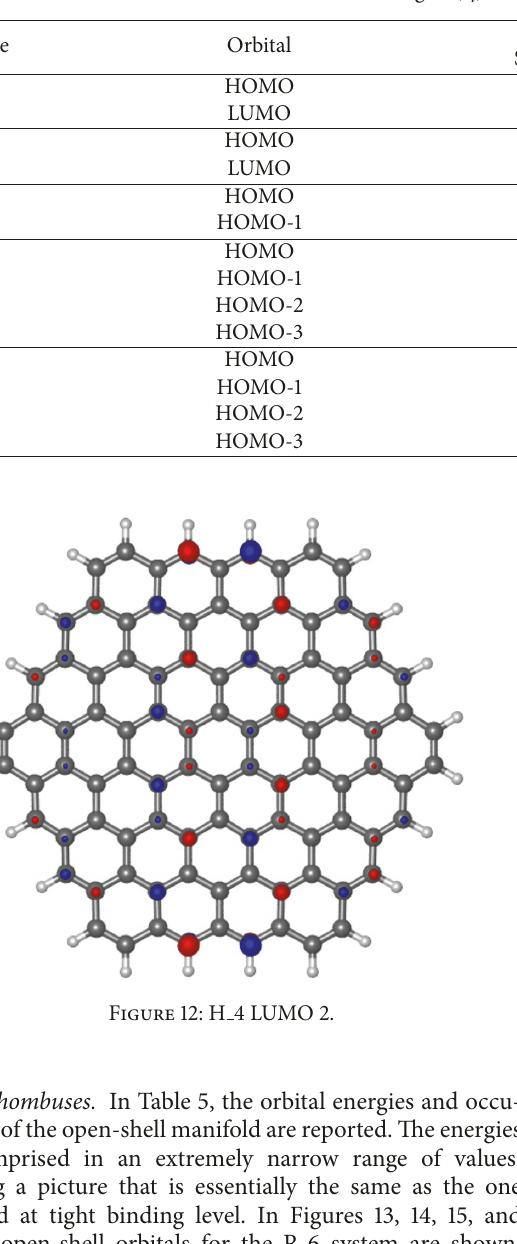
Table 5: Orbital energies ( 𝜖 𝑖 ) and occupancies ( 𝑛 𝑖 ) at RHF level for R n .